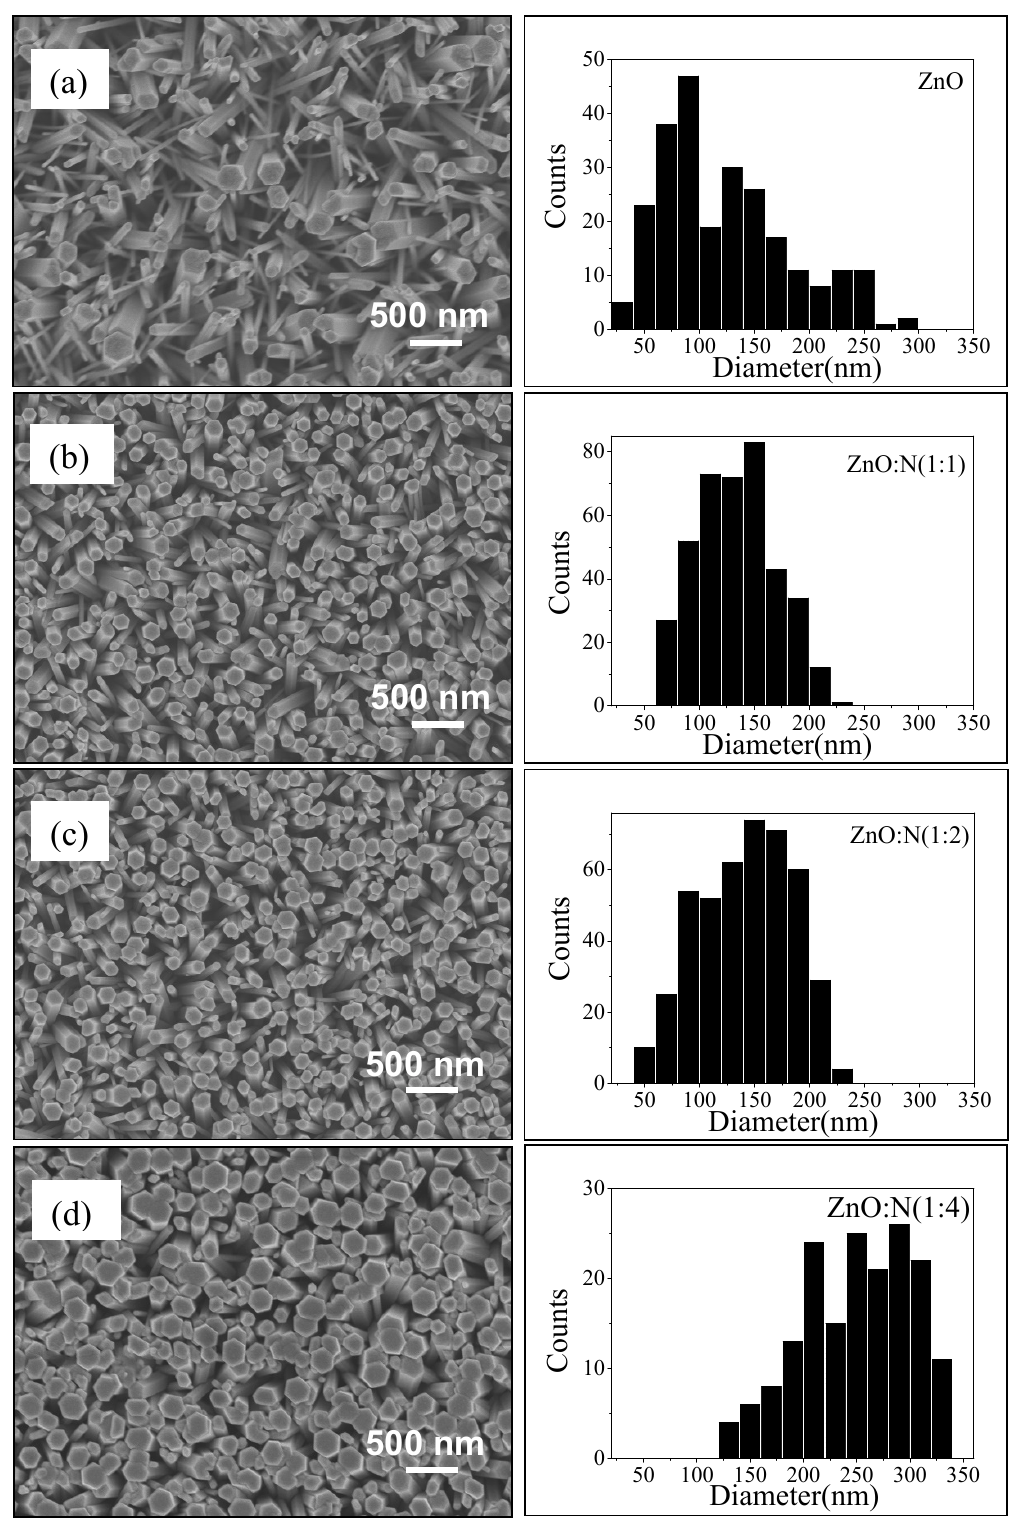
Figure 1. Left: electronic micrographs of ( a ) ZnO (1:0), ( b ) ZnO:N (1:1), ( c ) ZnO:N (1:2), and ( d ) ZnO:N (1:4); right: the corresponding NRs diameter distribution obtained through the software ImageJ.